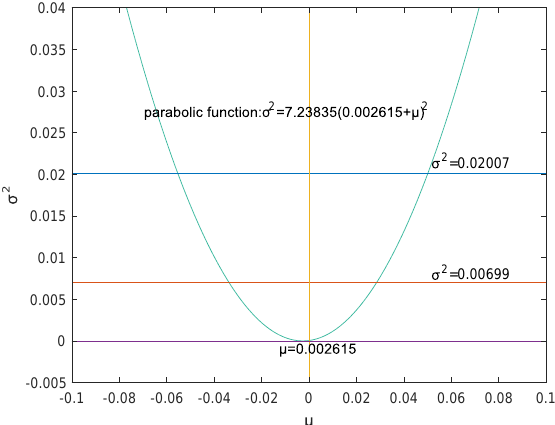
Figure 7. The joint confidence region of ( µ , σ 2 ) by area minimization